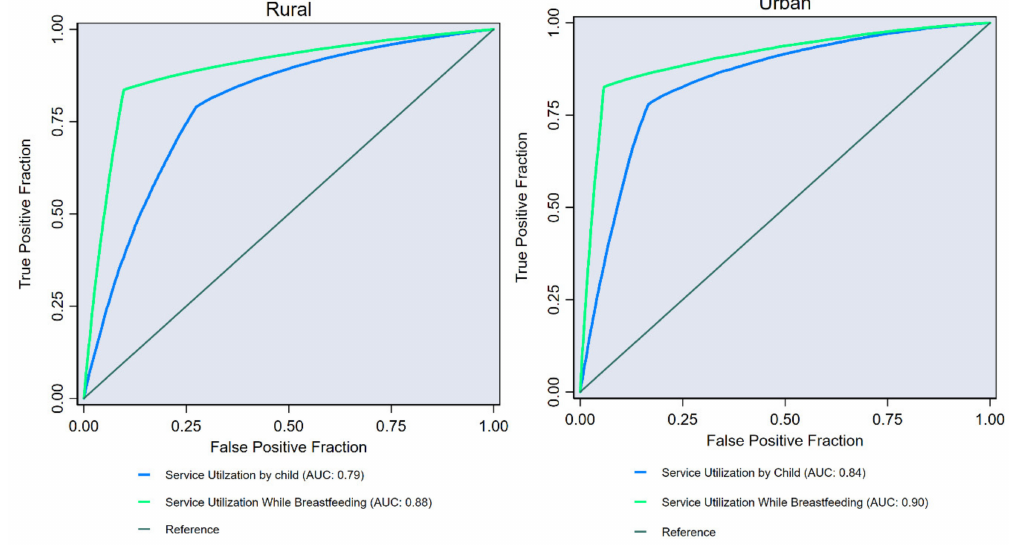
Figure 4. Areas under the receiver operating characteristic curve for ICDS service utilization by mother adjusted for ICDS service utilization by child and breastfeeding, India, NFHS,